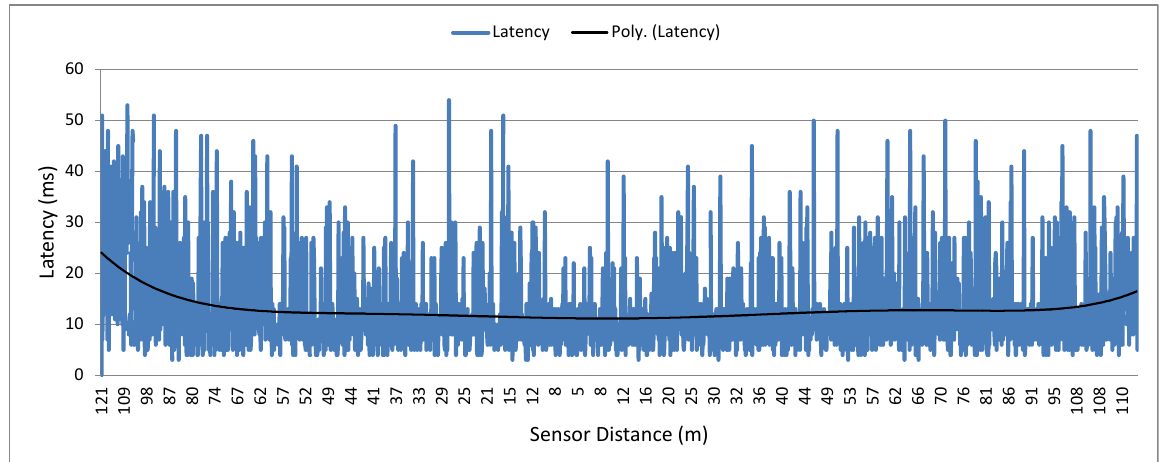
Figure 7. Sensor messages latency in the bicycle experiment.